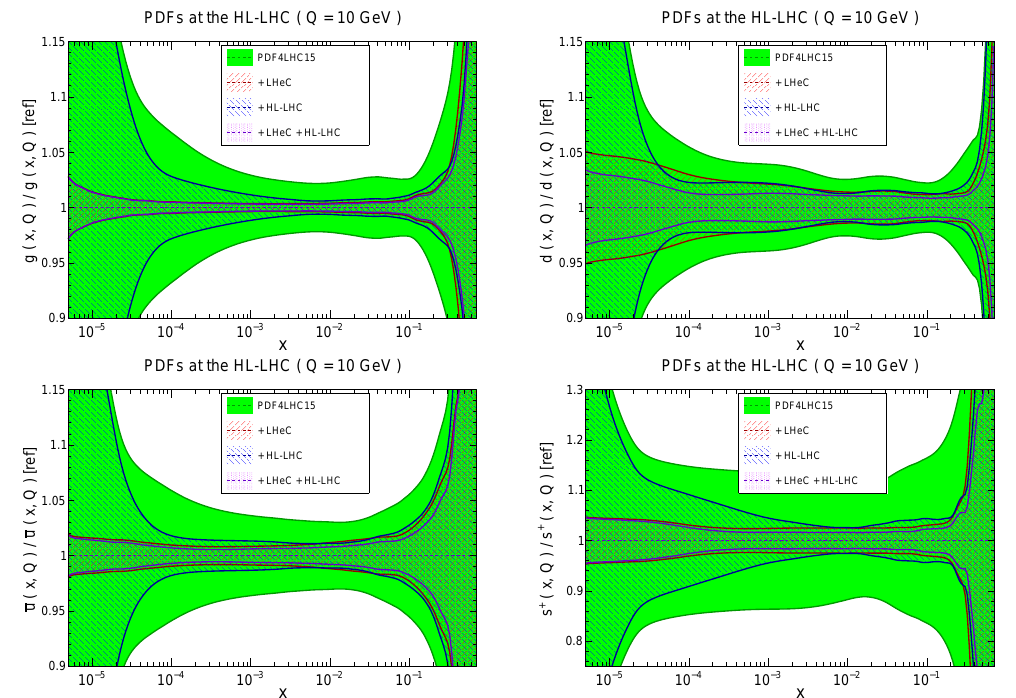
Figure 4.6: Same as Fig. 4.4, but with the error relative to each set